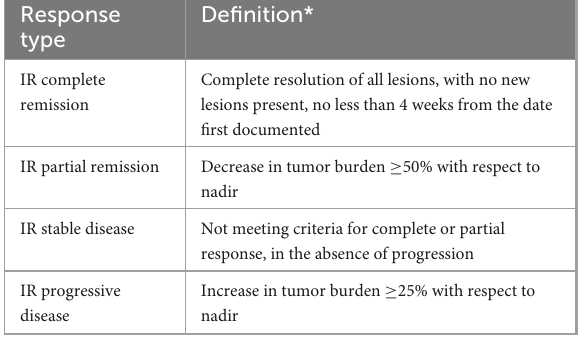
TABLE 3 LYRIC criteria: response assessment during follow-up for IR. Response type